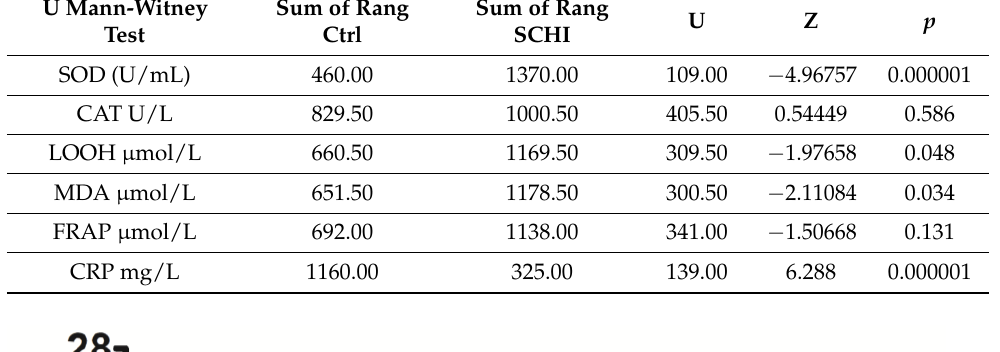
Table 2. Oxidative stress variables of patients versus control subjects. U Mann-Witney